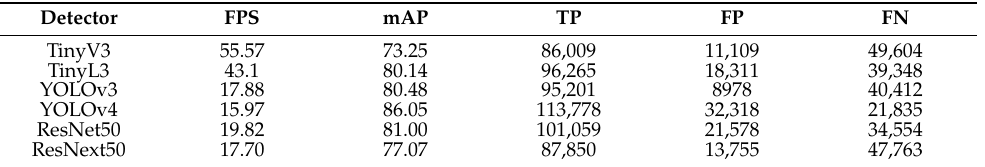
Table 3. Comparison of recognition rates for investigated detectors.